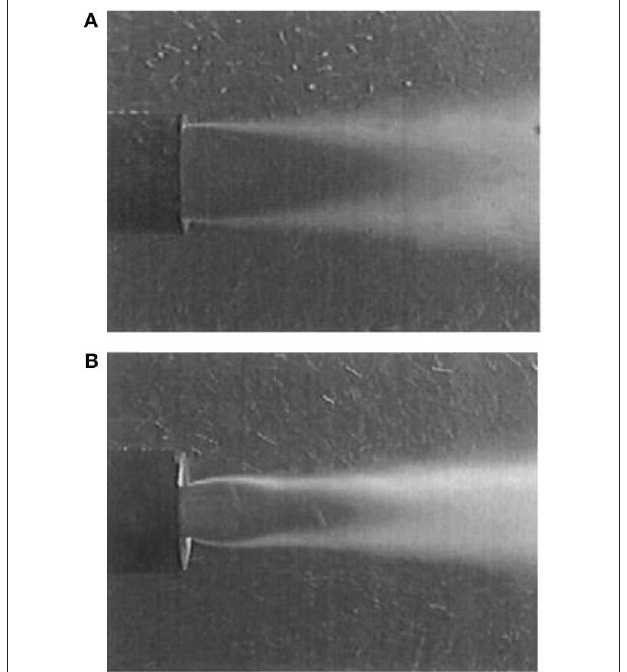
FIGURE 11 | The typical shapes observed by Hwan Kim et al. (2001). (A) Conical shape (nozzle ID: 20mm, mass flux: 280 kg/m2-s). (B) Ellipsoidal